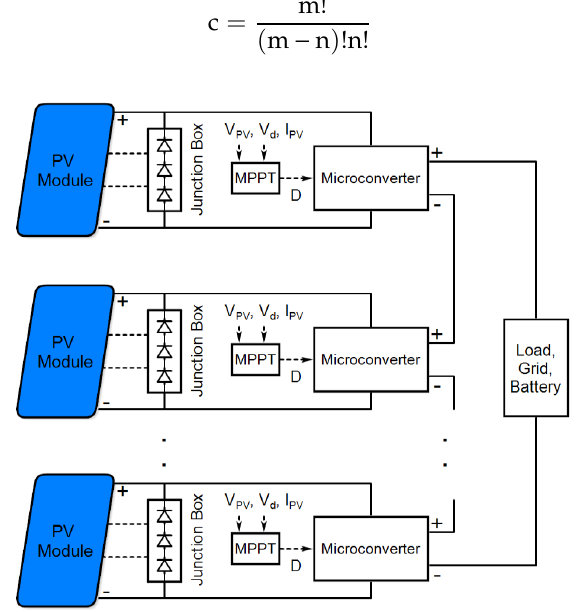
Figure 3. PV modules with several micro converters.